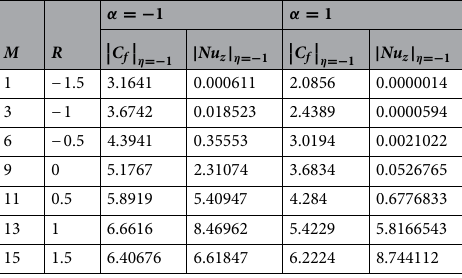
Table 6. Variation in C f and Nu z against (M) and ( R ) for ( HN fd ) (Cu– TiO 2 / water) when ϕ 1 = ϕ 2 = 0.01, α = − 1, Sc = 1, Pr = 6.2.